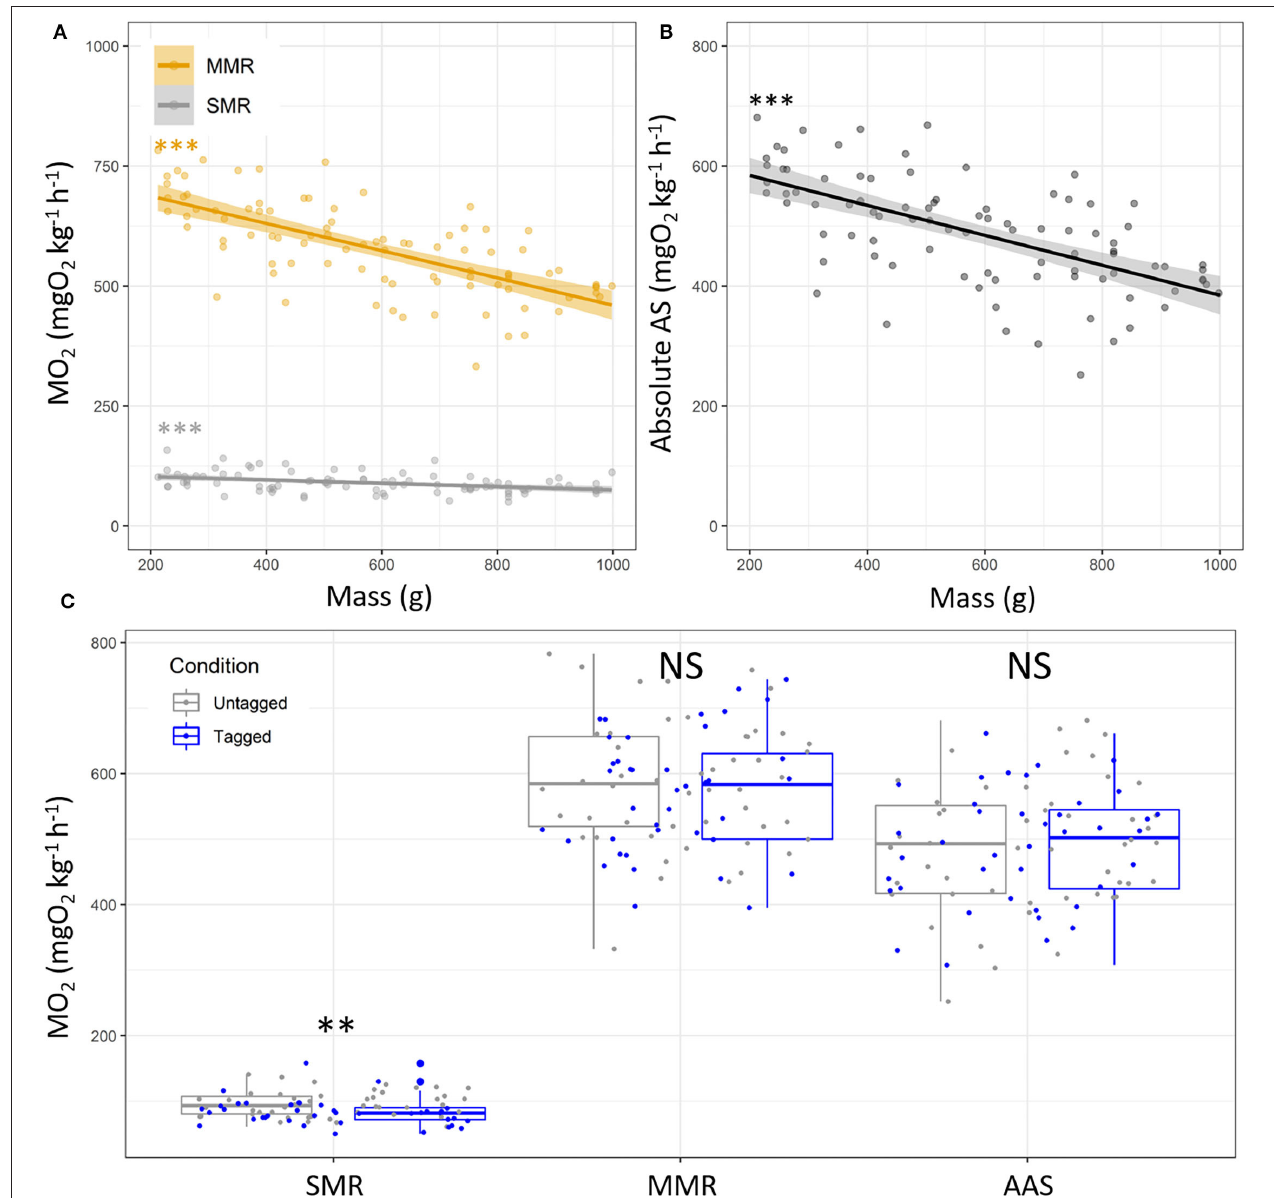
FIGURE 3 | Metabolic traits depending on fish mass in European sea bass ( Dicentrarchus labrax ; n = 90). (A) Standard and maximum metabolic rates (SMR, gray dots and MMR, orange dots), and (B) absolute aerobic scope (AAS; MO 2 , mgO 2 kg − 1 h − 1 ). Each dot represents the metabolic variables of a single fish. For panel (A) , the orange line represents linear regression for the MMR values. For panel (B) , the line represents linear regression, and the shape around represents the 95% confidence interval for the SMR, MMR and AS. Significance of the linear regressions is indicated in the two panels (A,B) [linear regression: ***: p < 0.001/not significant (NS)]. (C) Metabolic variables (SMR, MMR) and absolute AS for untagged ( n = 50, gray) and tagged ( n = 40, blue) European sea bass. For panel (C) , the significant differences are indicated for SMR, MMR, and AS depending on tagging condition [ t- test: **: p < 0.01/not significant